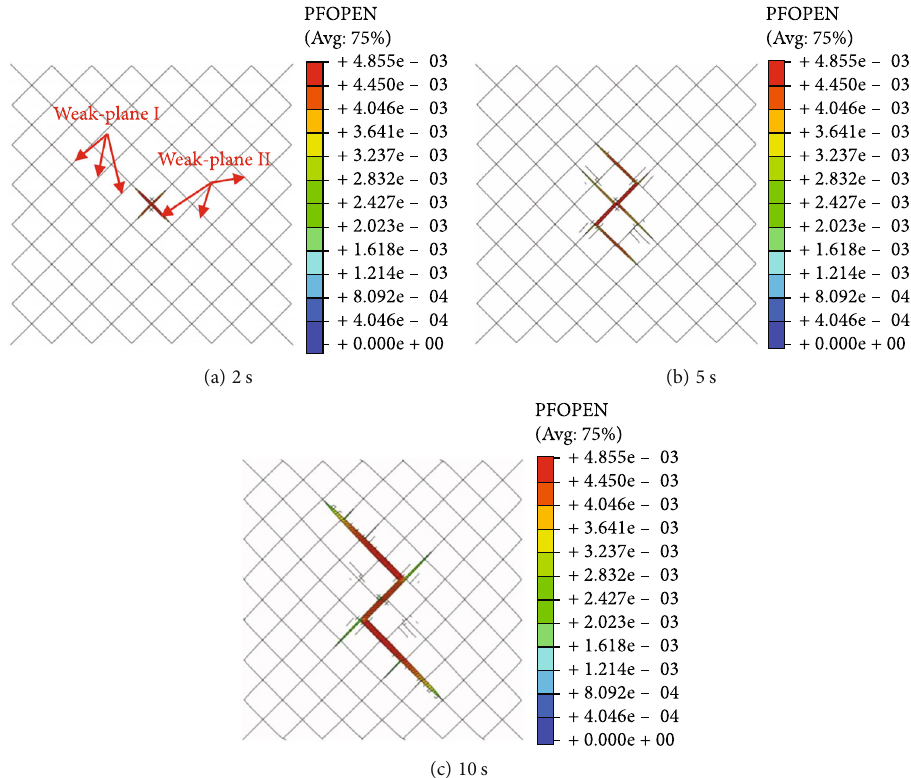
Figure 8: Opening distribution of weak plane type and matrix type fractures based on model